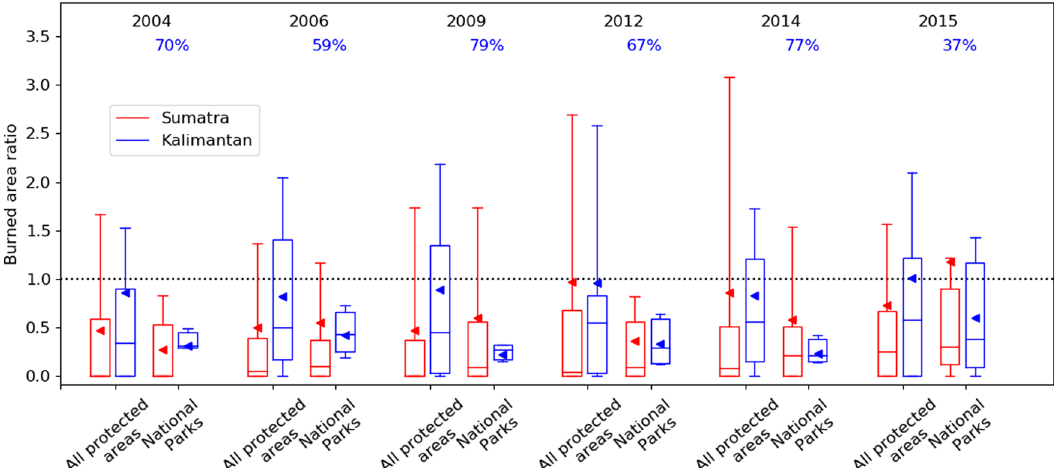
Fig. 2 The ratio of peatland burned area inside protected areas to outside of protected areas. For each protected area we compare fraction of peatland burned inside to outside (within 0.25° latitude and longitude of the protected area). Results are shown for Sumatra and Kalimantan for all protected area categories ( n = 31 and 22, respectively) and for National Parks ( n = 12 and 6, respectively) in each year. The box shows the upper and lower quartiles, the whiskers show the 95th percentiles, the lines show the median and the triangles the mean. The average percentage reduction in burned area inside the National Parks in Kalimantan in each year is shown in blue text.